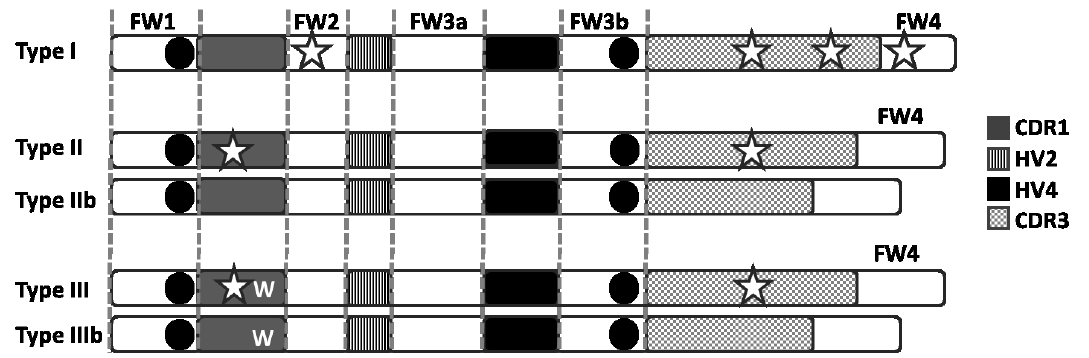
Figure 2. Representation of VNAR types. Black filler circles depict canonical cysteine residues; open stars depict non-canonical cysteine residues; FW, framework. The Type